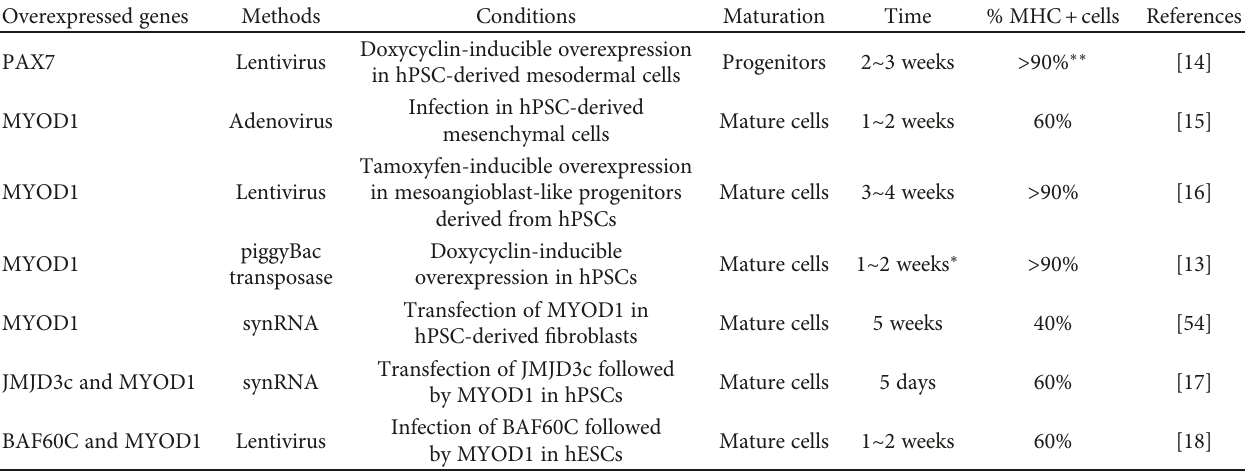
Table 1: Methods for the skeletal myogenic di ff erentiation of